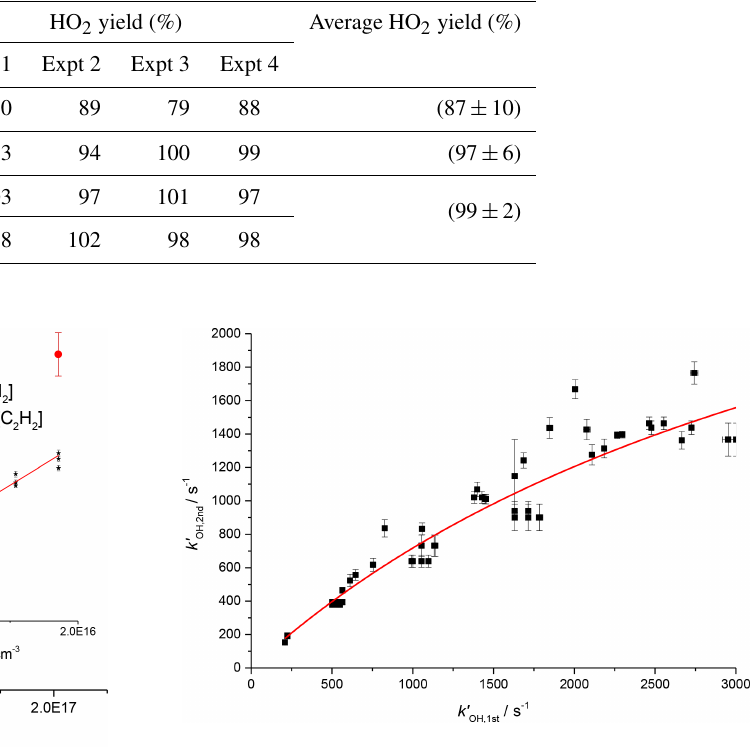
Figure 6. Relationship between the observed rate coefficient for the reaction of OH with H 2 O 2 observed in the first cell ( k OH , 1st ) and the observed OH removal rate in the second cell ( k OH , 2nd ). The dif- ference is non-linear but a simple fit to this could be used to assign removal rates to traces observed in the second cell below 2500s − 1 . The red line is the simplified fit of the form, y = A · ( 1 − e − b · x ) , where A was some limit value above which no increase in measured rate coefficient would be